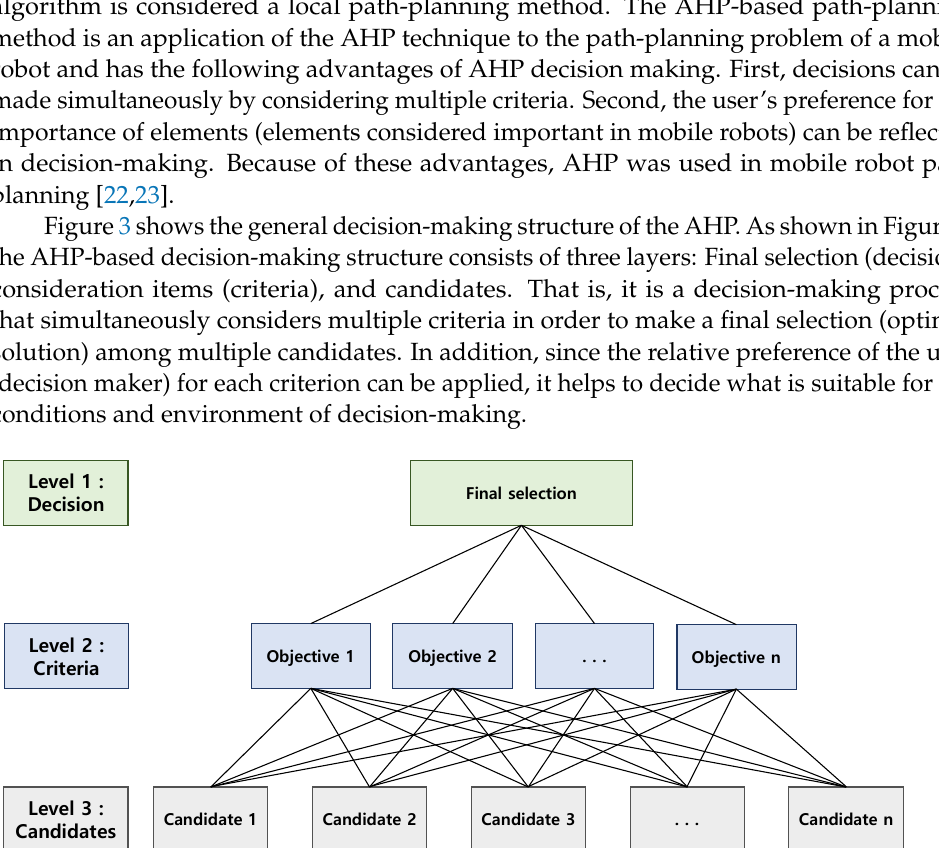
( b ) Figure 4. Structure of AHP-based mobile robot path planning: ( a ) AHP structure; ( b ) AHP decision making situation. Figure 5 shows the results of AHP path planning under the same conditions as the A-STAR-based path planning. The importance of each criterion of AHP was defined as 𝑂 (cid:2869) = 0.70, 𝑂 (cid:2870) = 0.19 , and 𝑂 (cid:2871) = 0.11 , respectively. The total moving distances are 168.5 m and infinite, one is shorter than that of A-STAR. The first case is because A-STAR defines 8 cells surrounding each cell as the moving position, while AHP defines the points at the